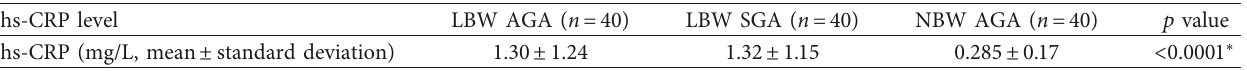
Table 4: Association between the three birth weight groups and serum hs-CRP level.